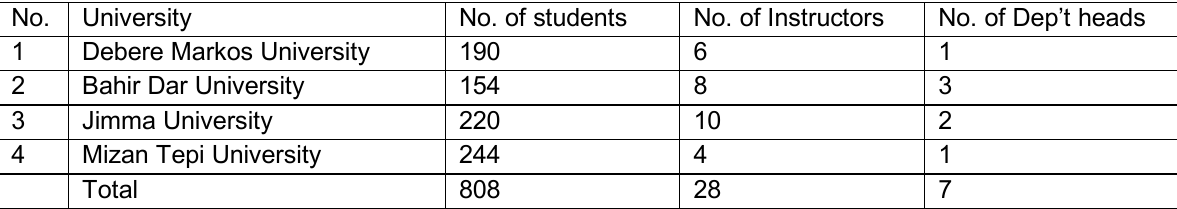
Table 1: Numbers of sample